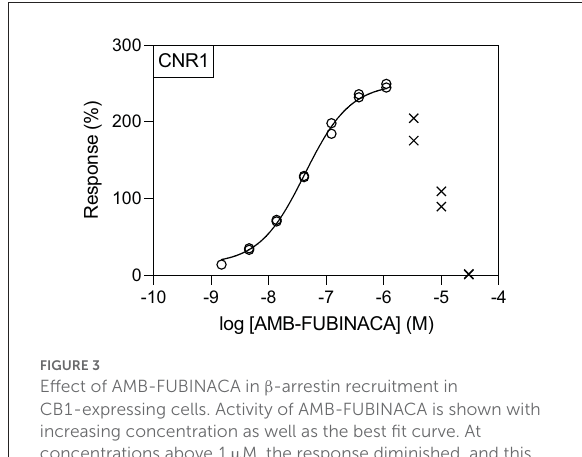
FIGURE3 Effect of AMB-FUBINACA in β -arrestin recruitment in CB1-expressing cells. Activity of AMB-FUBINACA is shown with increasing concentration as well as the best fit curve. At concentrations above 1 µ M, the response diminished, and this data was excluded from the curve fitting